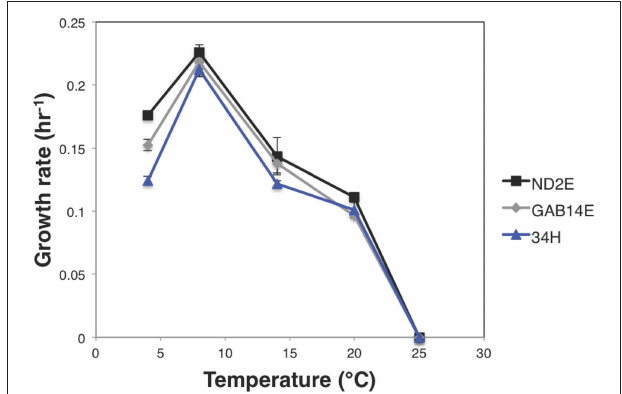
FIGURE 2 | Growth rate vs. temperature. Strains were grown in marine broth at different temperatures. Growth rate was calculated for each temperature and strain and growth rate was plotted as function of temperature for each strain. Error bars represent the standard error for three biological replicates. Strain 34H is shown in blue, ND2E is shown in black, and GAB14E is shown in